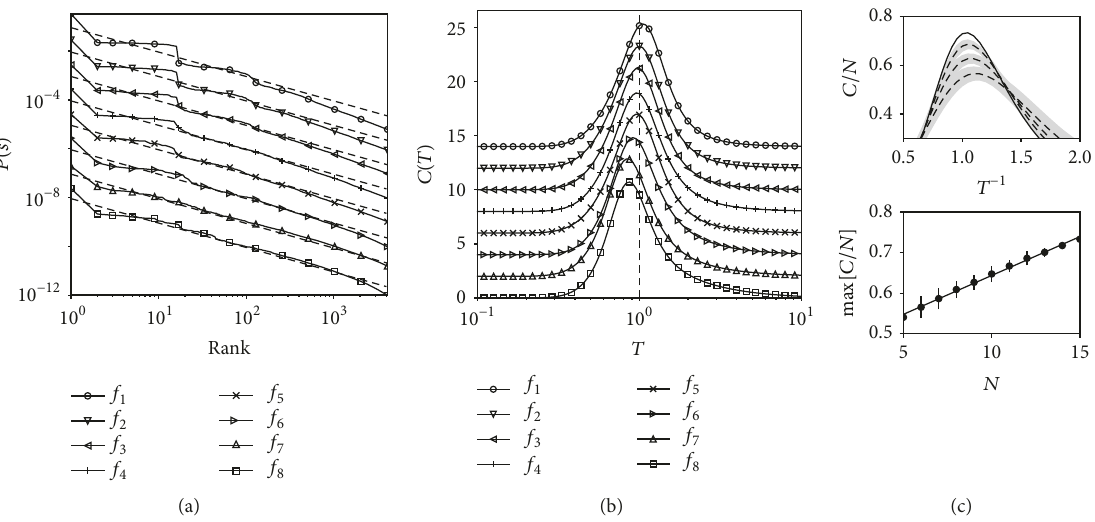
Figure 2: Signatures of criticality. (a) Ranked probability distribution function of the inferred Ising models for the different frequency bands (solid lines) versus a distribution following Zipf’s law (i.e., 𝑃(𝑠) = 1/ rank, dashed lines). (b) Heat capacity versus temperature for the inferred Ising models for different frequency bands. Temperature 𝑇 = 1 is the point where our models are poised, coinciding with a divergence of the heat capacity. Lines are shifted vertically in order to facilitate visualization. (c) Divergence of the normalized heat capacity with the size of the system, showing (top) the peaks of the normalized heat capacity averaged over 100 Ising models at 𝑓 5 for sizes 6, 9, and 12 (dashed lines) and 15 (solid line) and (bottom) linear trend of the peak maxima of the averaged heat capacity for sizes 5 to 15. Grey areas represent the error bars.